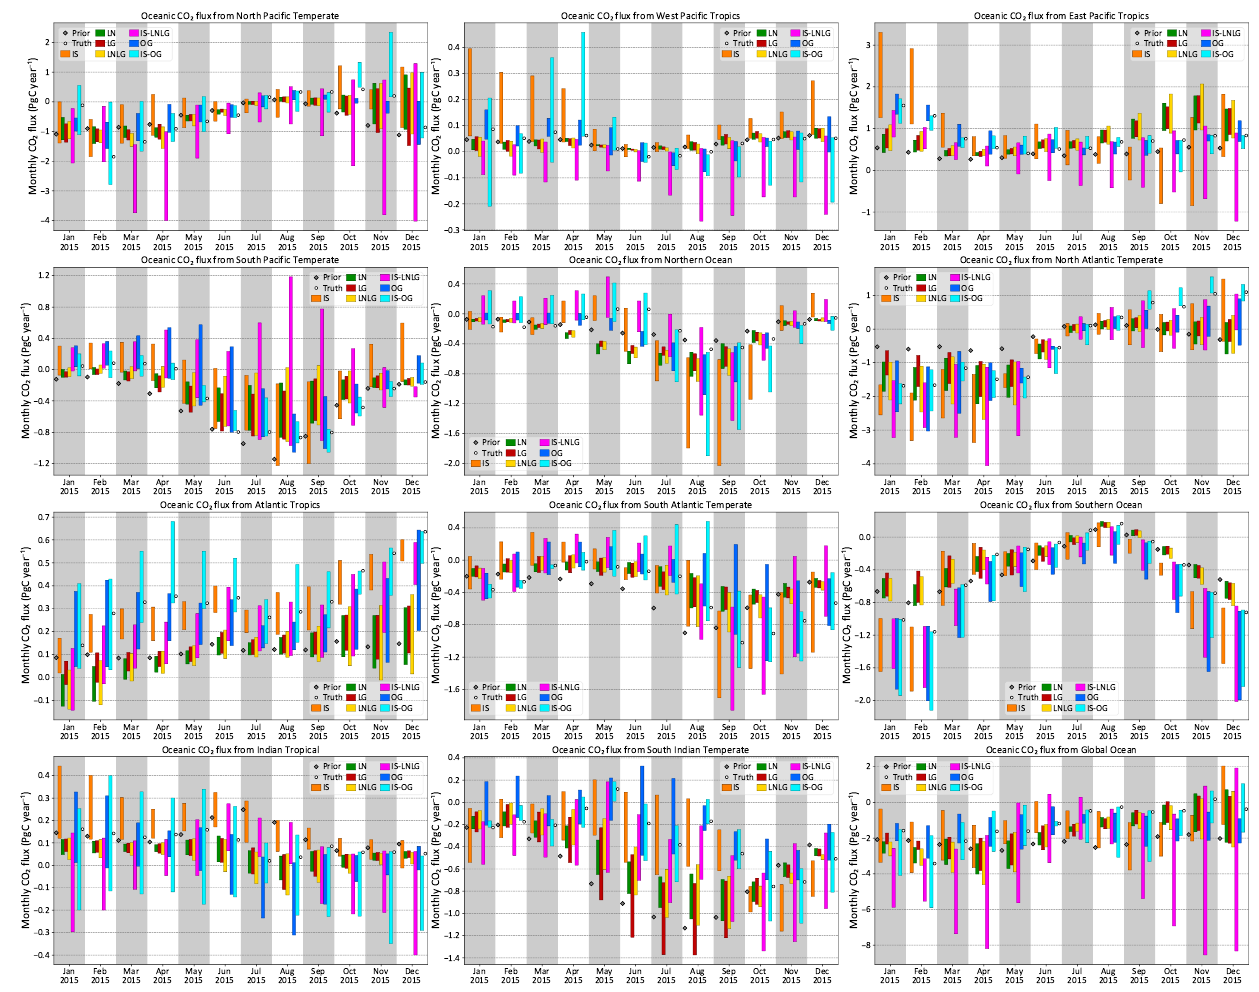
Figure 6. Same as Fig. 5 except over TRANSCOM ocean regions and global total ocean.